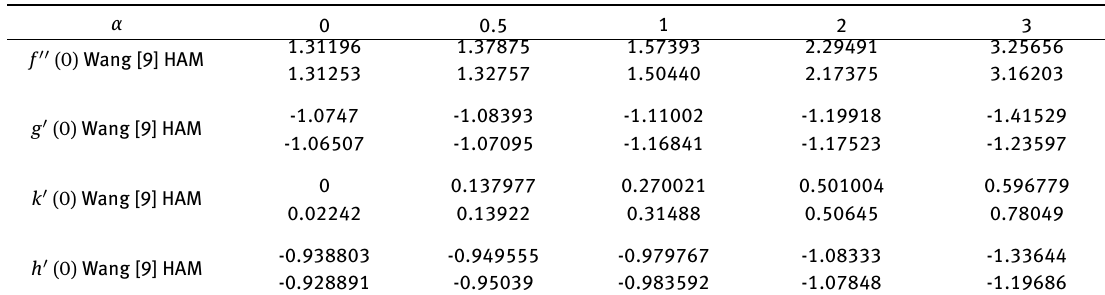
Table 1: Illustrating the variation of f (cid:48)(cid:48) (0) g (cid:48) (0) k (cid:48) (0) , and h (cid:48) (0) for various values of α at the approximation level m =9 ( We = 0, λ = 0 , M = 0, f w = 0, (cid:126) = −0.25)